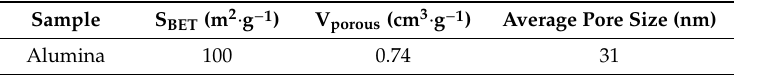
Table 2. Specific surface area and porous volume of alumina.